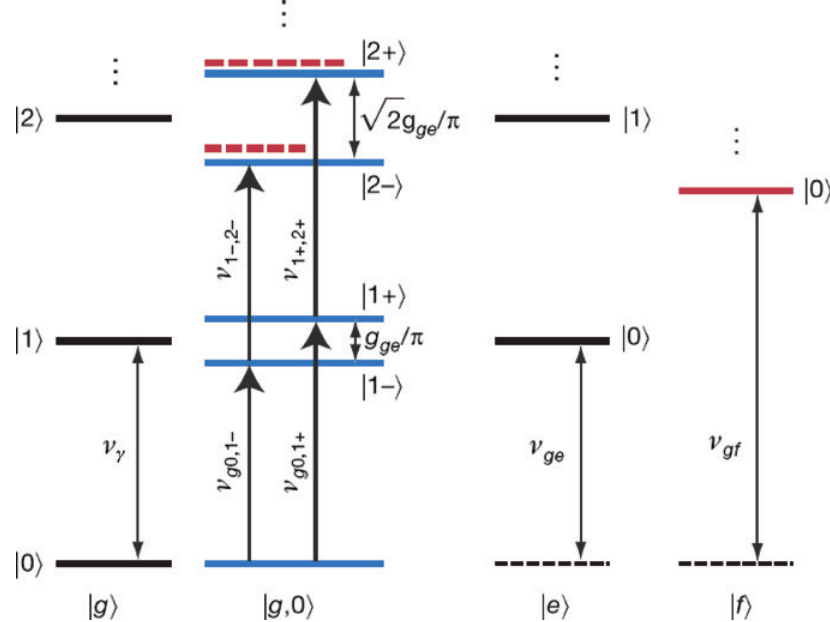
Figure 4: Diagram shows a resonant cavity-QEDs. 〉 〉 | , | , g f and 〉 | e are uncoupled qubit states and 〉 〉 |0 , |1 , and 〉 |2 are photon states. ν of transition between the ground state 〉 | g and the excited state 〉 | . e The blue line represents the dipole-coupled dressed states. The energy of all ground states is represented by black lines. Pump and probe transitions are given as ( ν respectively